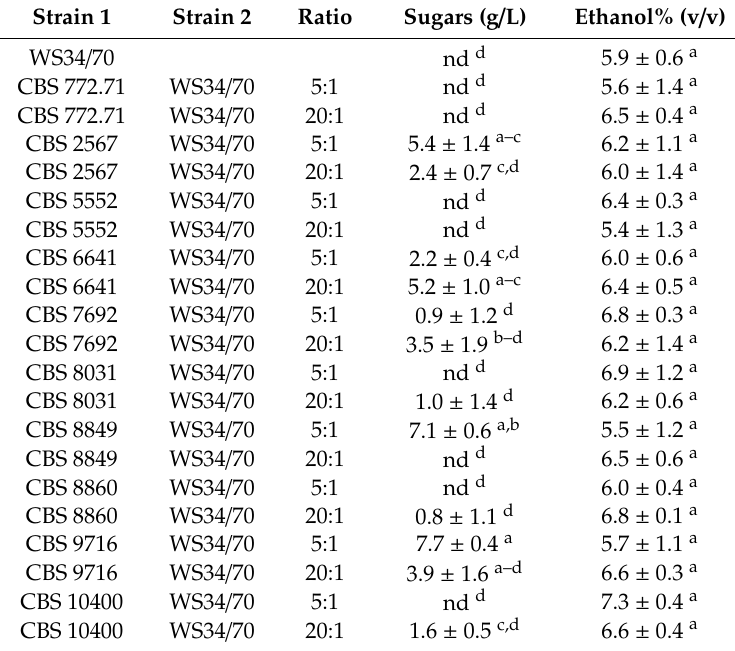
Table 5. Residual sugars and ethanol in the resulting